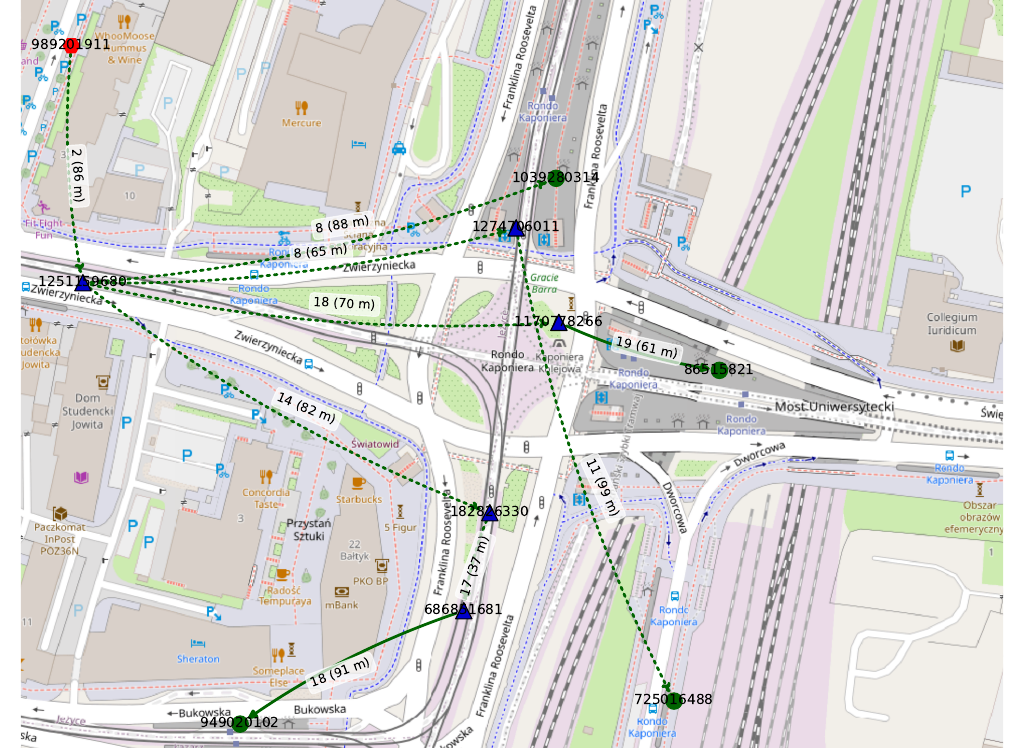
Figure 13. Opportunistic spatiotemporal shortest paths to selected